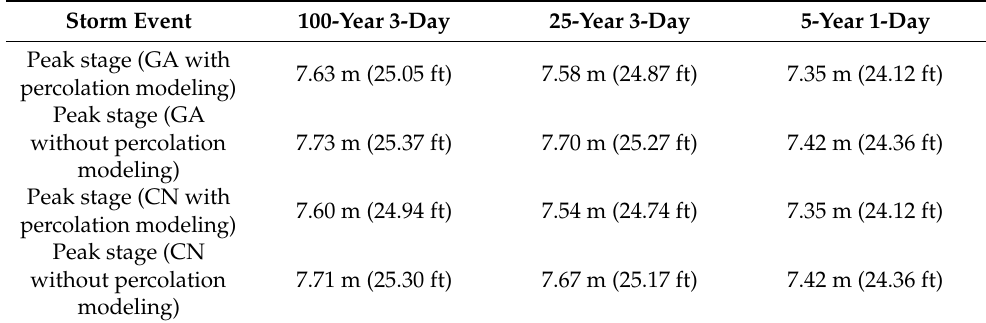
Table 8. Summary of the peak stages for the ICPR model